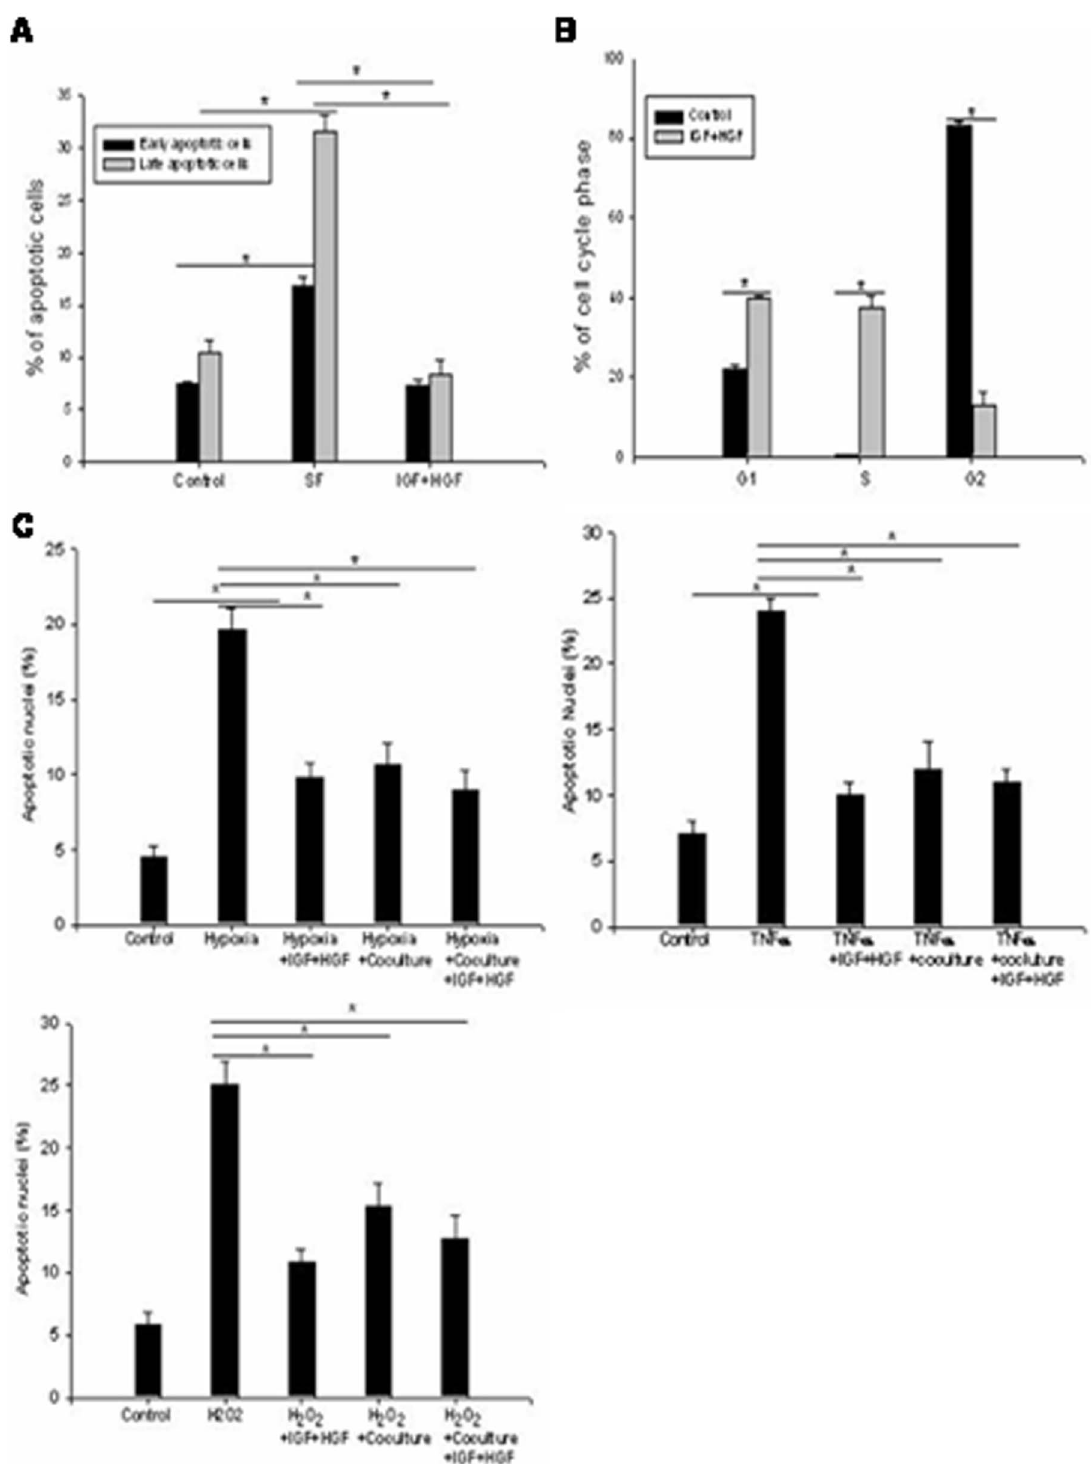
Figure 5. Invitro data showing that IGF + HGF stimulation enhances Sca-1 + /CD31 2 cell survival and proliferation and protects co- cultured stressed HL-1 from apoptosis. ( A ) . FACS analysis showed that IGF + HGF treatment significantly decreased serum free medium induced Sca-1 + /CD31 2 cell apoptosis (n=6, P , 0.01). Apoptotic cells were determined using FITC Annexin V staining. ( B ) . FACS analysis demonstrated that IGF + HGF treatment stimulated Sca-1 + /CD31 2 cells to enter the cell cycles as indicated by more cells entering G1 and S phases (n=6, P , 0.01). ( C ) . Addition of IGF + HGF to HL-1 cells or co-culture of the cells with Sca-1 + /CD31 2 cells inhibited stressor (hypoxia, H 2 O 2 and TNF a ) induced HL-1 cell apoptosis (n=6, P , 0.001). Data are presented as mean + / 2 SEM.